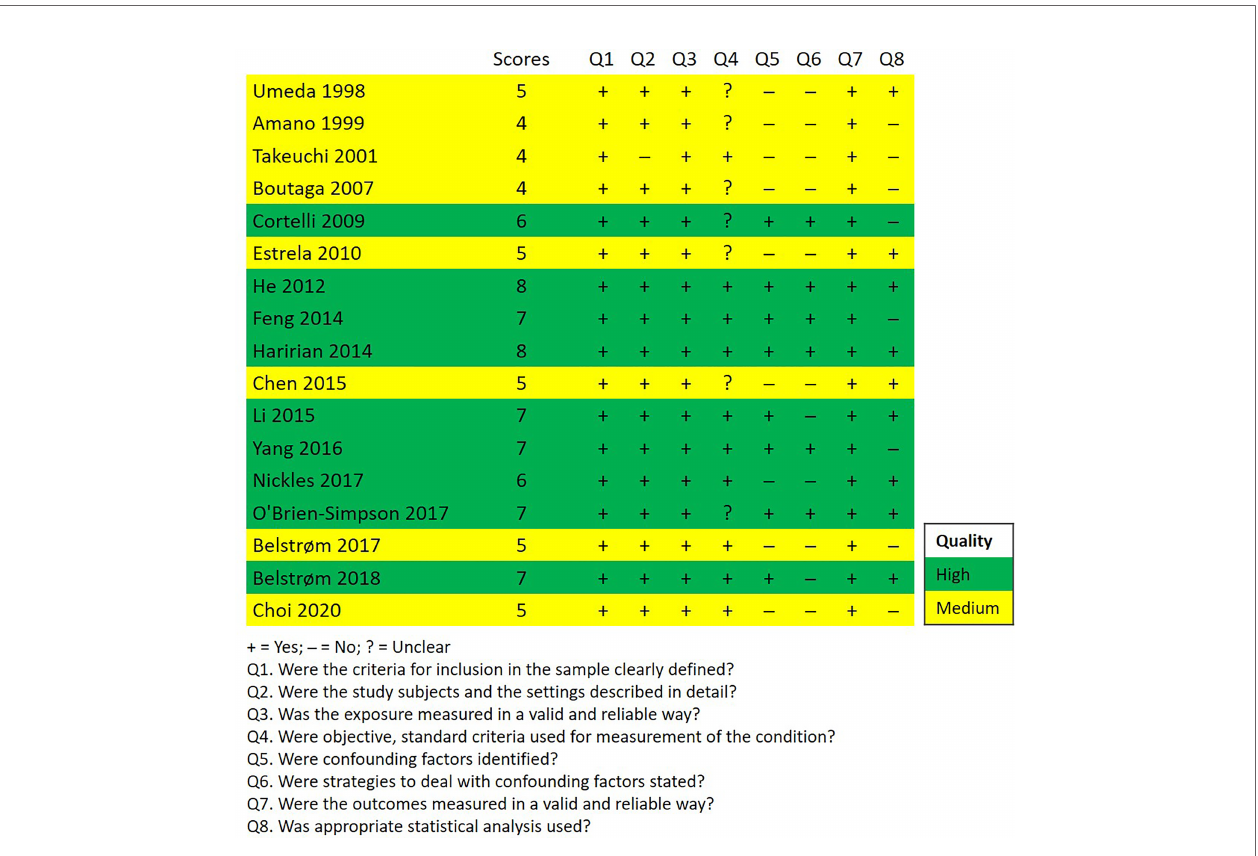
FIGURE 2 | Quality assessment of the included studies according to the JBI Critical Appraisal Checklist for Analytical Cross-Sectional